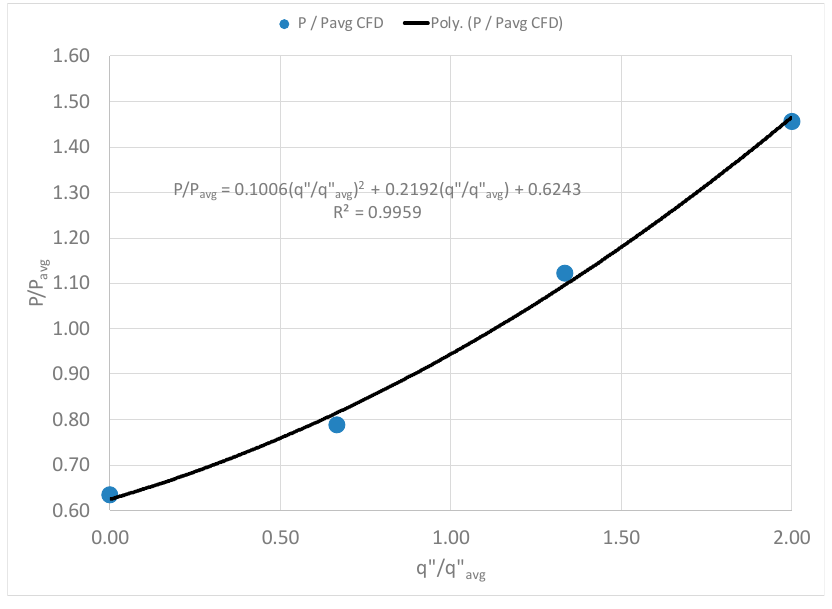
Figure 24. Effect of parasitic heat flux on windage losses for P avg = 152 W, q ” avg = 5295 W/m 2 .